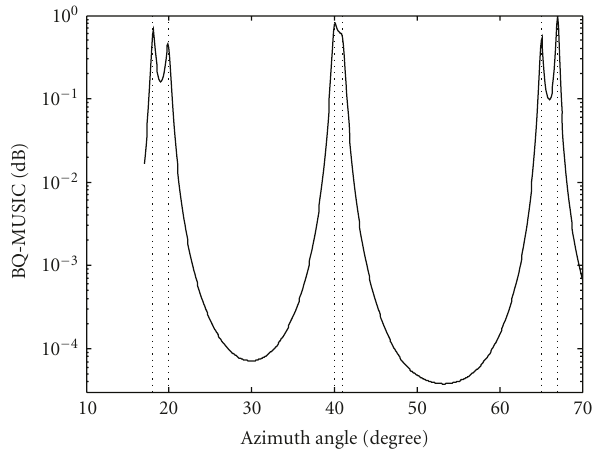
Figure 11: BQ-MUSIC spectrum in the presence of several close signals; SNR = 30 dB, the number of snapshots is 100.